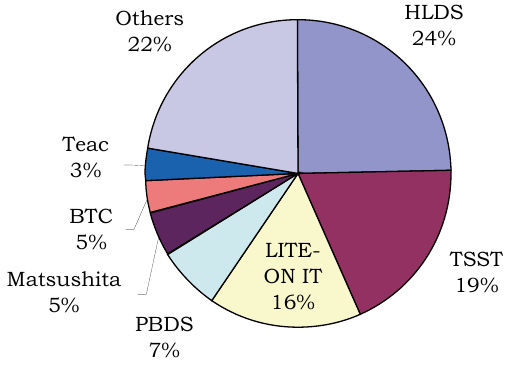
Figure 3. World market share of optical